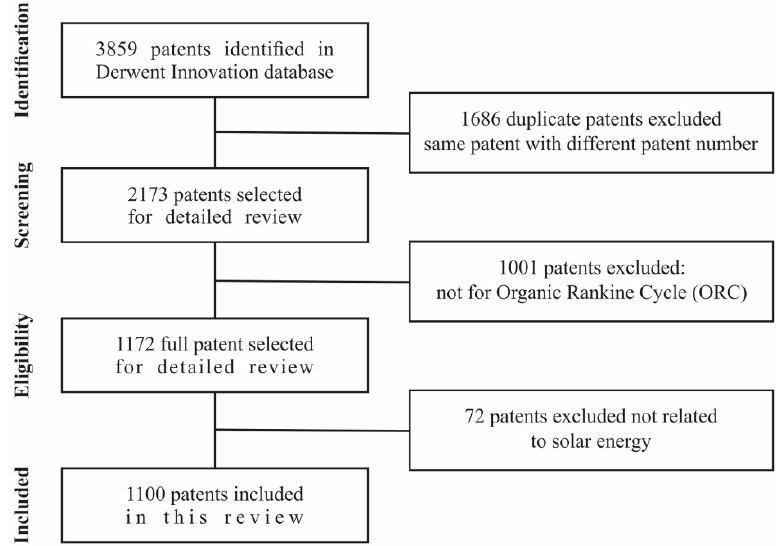
Figure 3. Flowchart of process adopted to review patents results; based on PRISMA Statement [68].